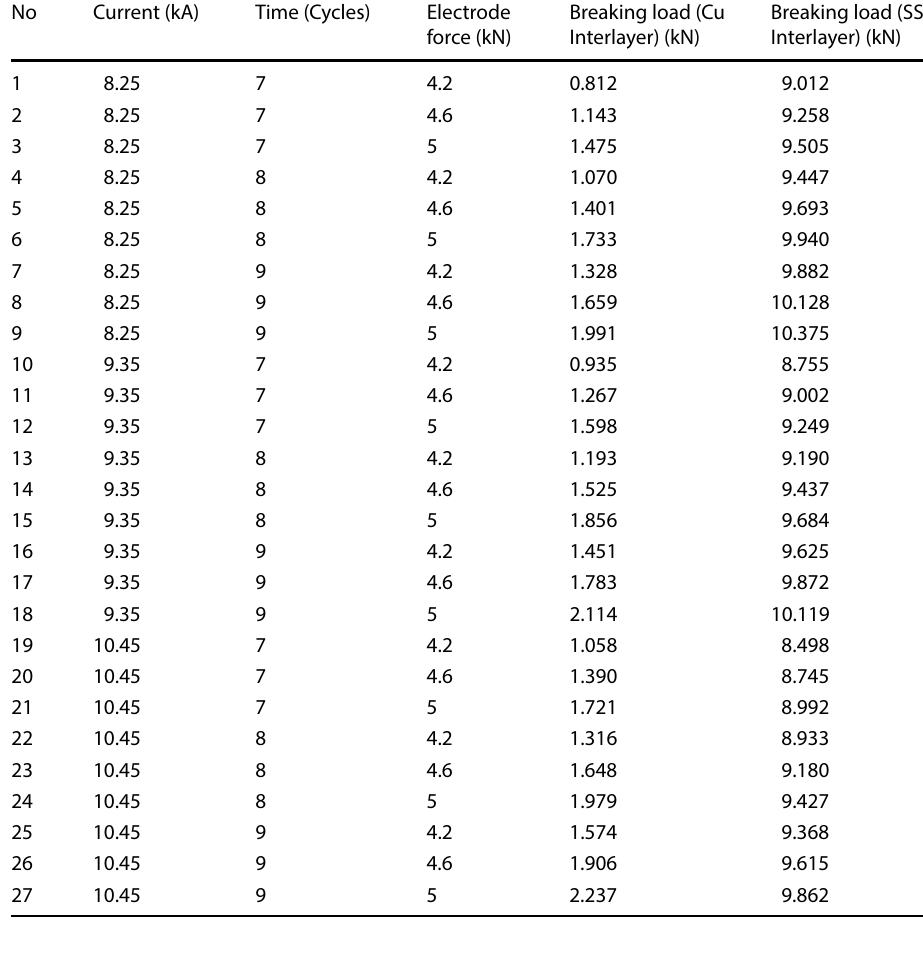
Table 4 Breaking Load for welded joints with Interlayer